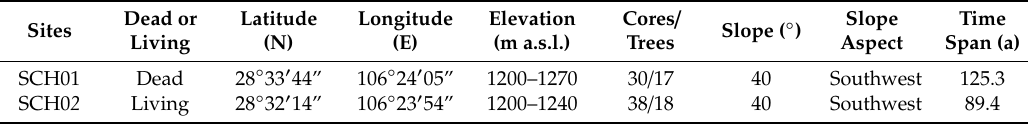
Table 1. Characteristics of sampling